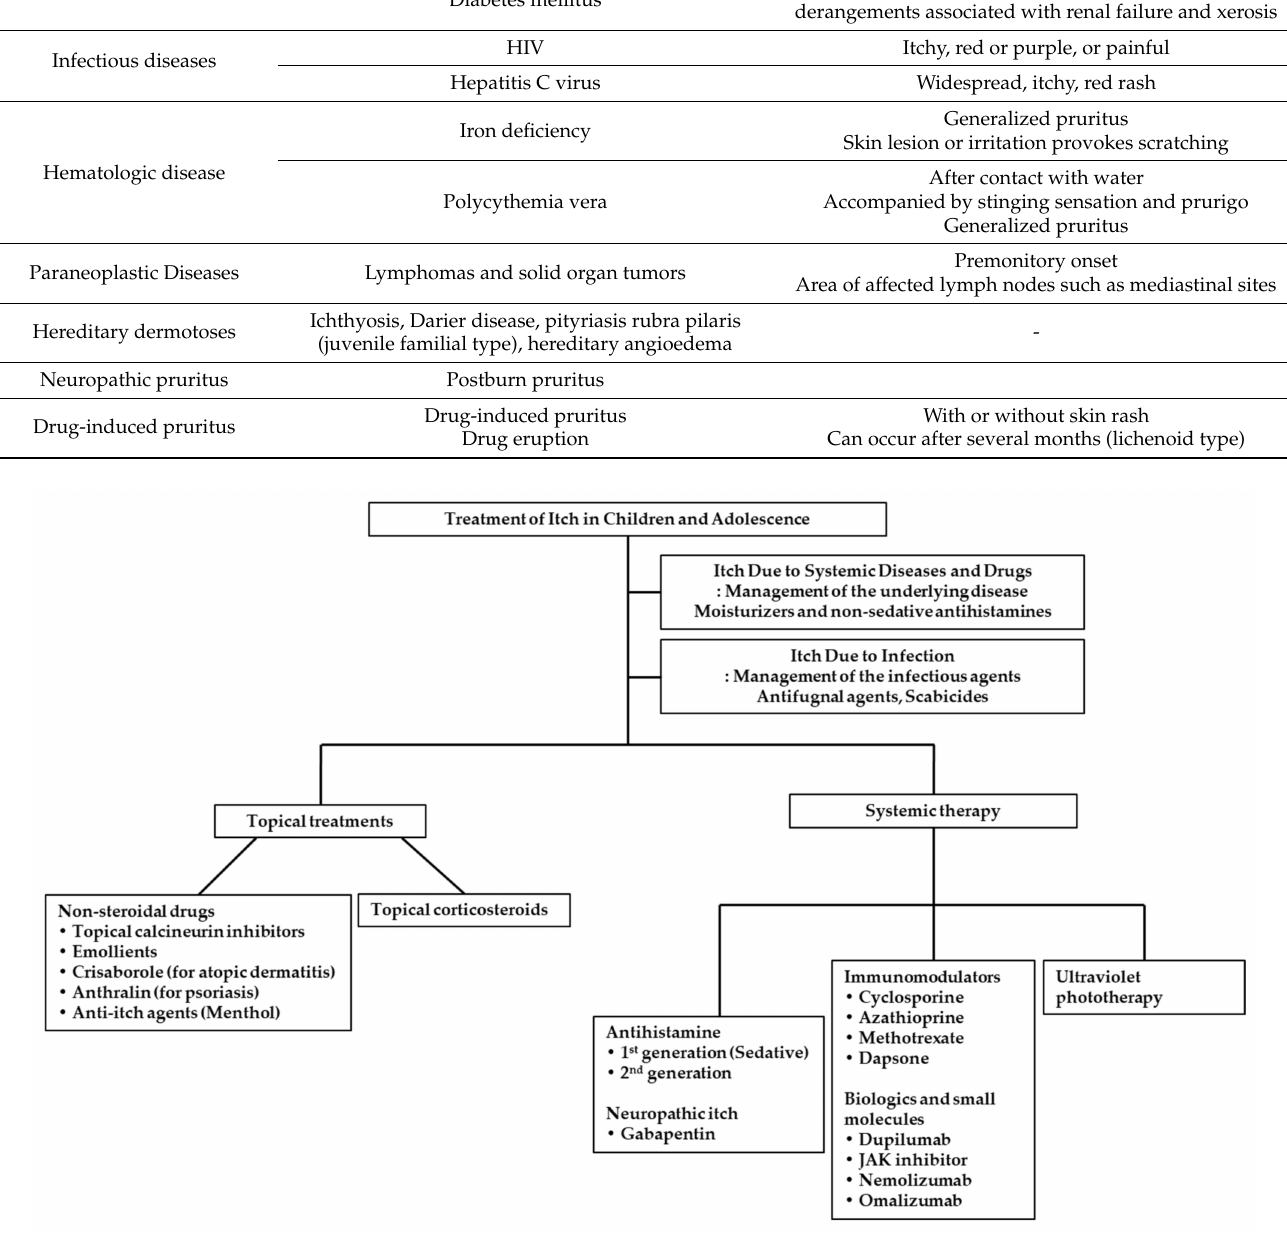
Figure 3. Therapeutic options for itching in children and